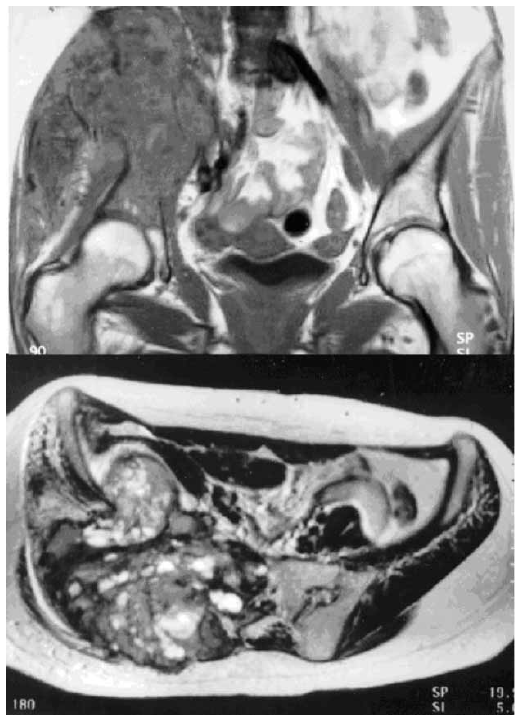
Fig. 1. Tumor affecting the right pelvis: MRI. T1 and T2 sequences; T2 marks the fluid-filled spaces within the